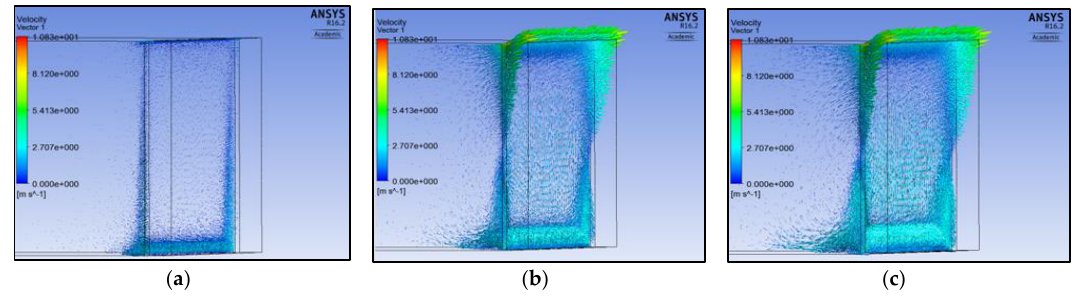
Figure 5. Sequence of the velocity vectors at different time at the exit of the furnace: ( a ) Velocity vectors at 0 s; ( b ) Velocity vectors at 0.5 s; ( c ) Velocity vectors at 1 s.